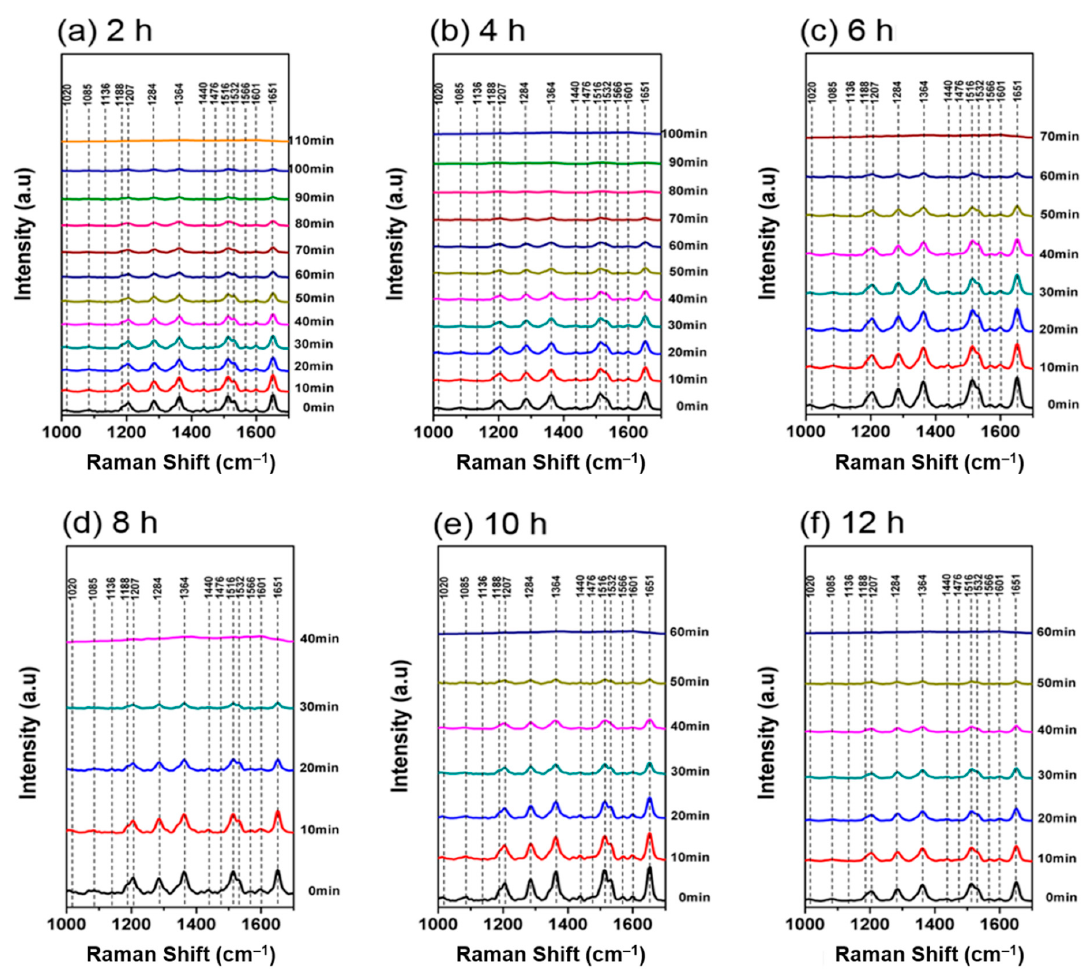
Figure 6. SERS monitoring of photocatalytic degradation of Rhodamine B (10 − 3 M), substrate at different AgNP deposition times—( a ) 2 h, ( b ) 4 h, ( c ) 6 h, ( d ) 8 h, ( e ) 10 h, and ( f ) 12 h.